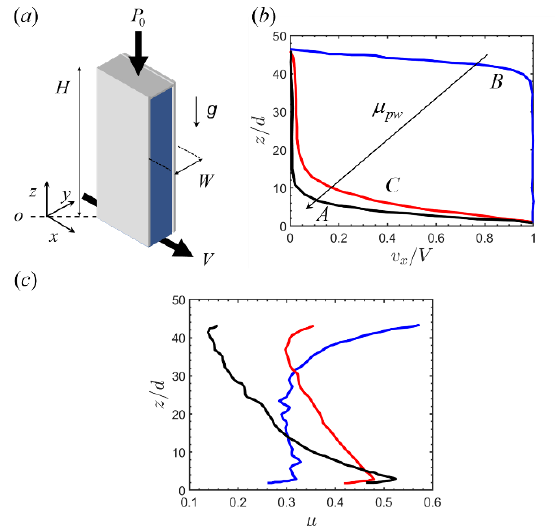
Fig. 1. (a) Wall-bounded flow configuration. Profiles of (b) normalized depth velocity and (c) effective bulk friction coefficient with varying lateral wall friction for Fr=10 and M =0.2 (data are extracted from